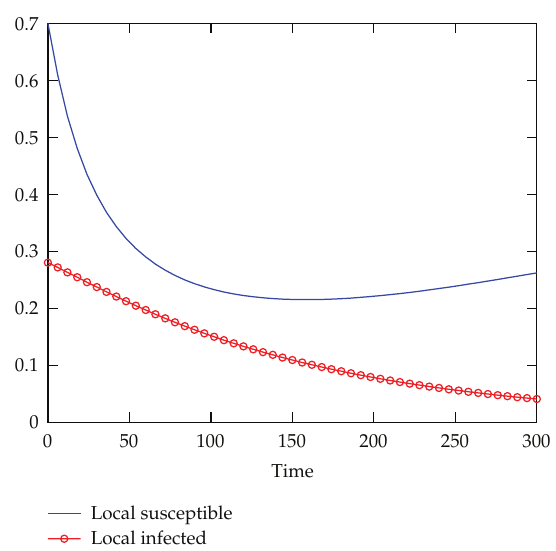
Figure 2: This plot shows the proportions of susceptible and infected individuals in the local subpopulation, according to Example 4.2.